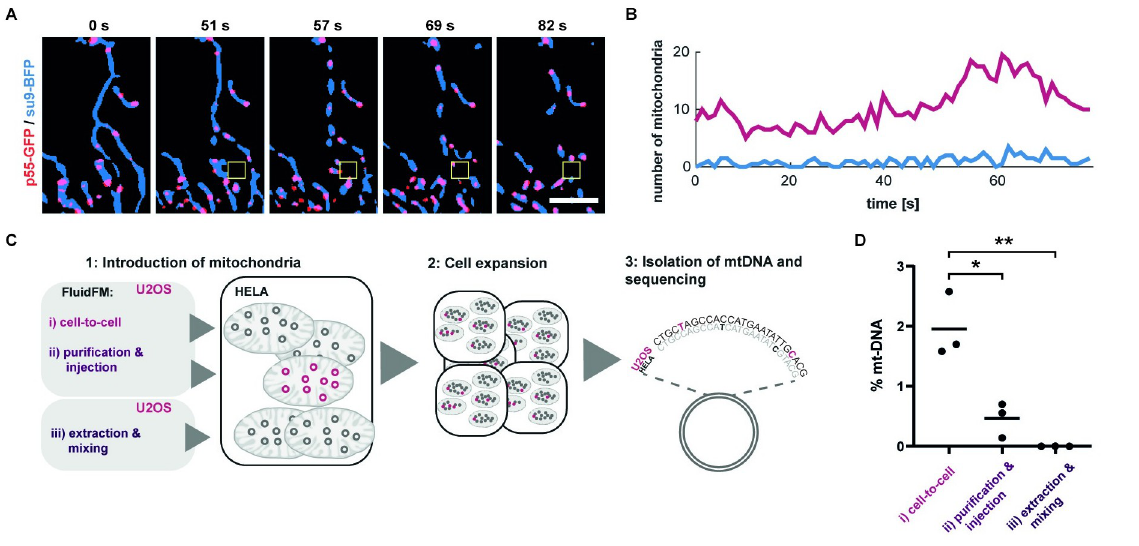
Fig 5. Mitochondria transplantation and transfer of mitochondrial genomes. ( A ) Time-lapse evaluation of mitochondria extraction visualizing mitochondrial nucleoids. An overlay of mitochondrial matrix shown in blue (su9-BFP) and mitochondrial nucleoids shown in red (p55-GFP). Yellow box indicates position of the cantilever. (B ) Dynamic localization of labeled nucleoids within a fractionating mitochondrial network. Plotted are the total amounts of mitochondria (su9-BFP) that show overlap with a labeled nucleoid (p55-GFP) in red and idle mitochondria showing no fluorescent trace of p55-GFP in blue over time. See also S13 Fig. Scale bar: 5 μ m. ( C ) Strategy for the quantification of mtDNA maintenance after mitochondrial transplantation. ( D ) Quantification of retained U2OS mtDNA in transplanted HeLa cells of all approaches tested. Bars indicate mean value. Difference between condition i and ii, p = 0.0138 and between condition i and iii, p = 0.0034. The data underlying Fig 5B and 5D can be found in S1 Data. mtDNA, mitochondrial